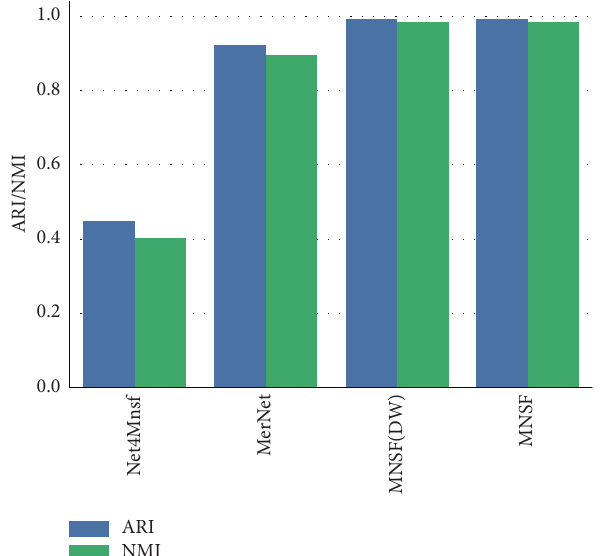
Figure 10: The ARI and NMI scores of different verification al- gorithms in CKM dataset.